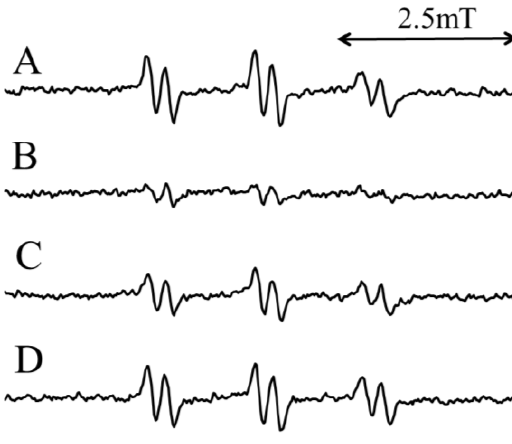
Figure 6. ESR spectra of the standard D O reaction mixtures (I) and (II) irradiated with 2 visible light at 436 nm. Reaction and ESR conditions are as described in the Experimental Section. ( A ) Standard D O reaction mixture (I); ( B ) Standard D O reaction mixture (I) with 2 2 2 mM CA, which was added before irradiation; ( C ) Standard D O reaction mixture (II); 2 ( D ) Standard D O reaction mixture (II) with 1.7 mM CA, which was added after 2